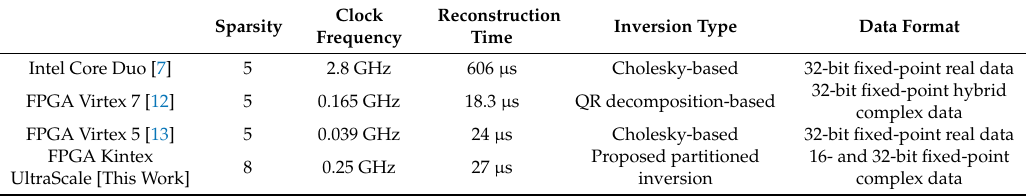
Table 5. Performance comparison for the 32 × 128 measurement matrix